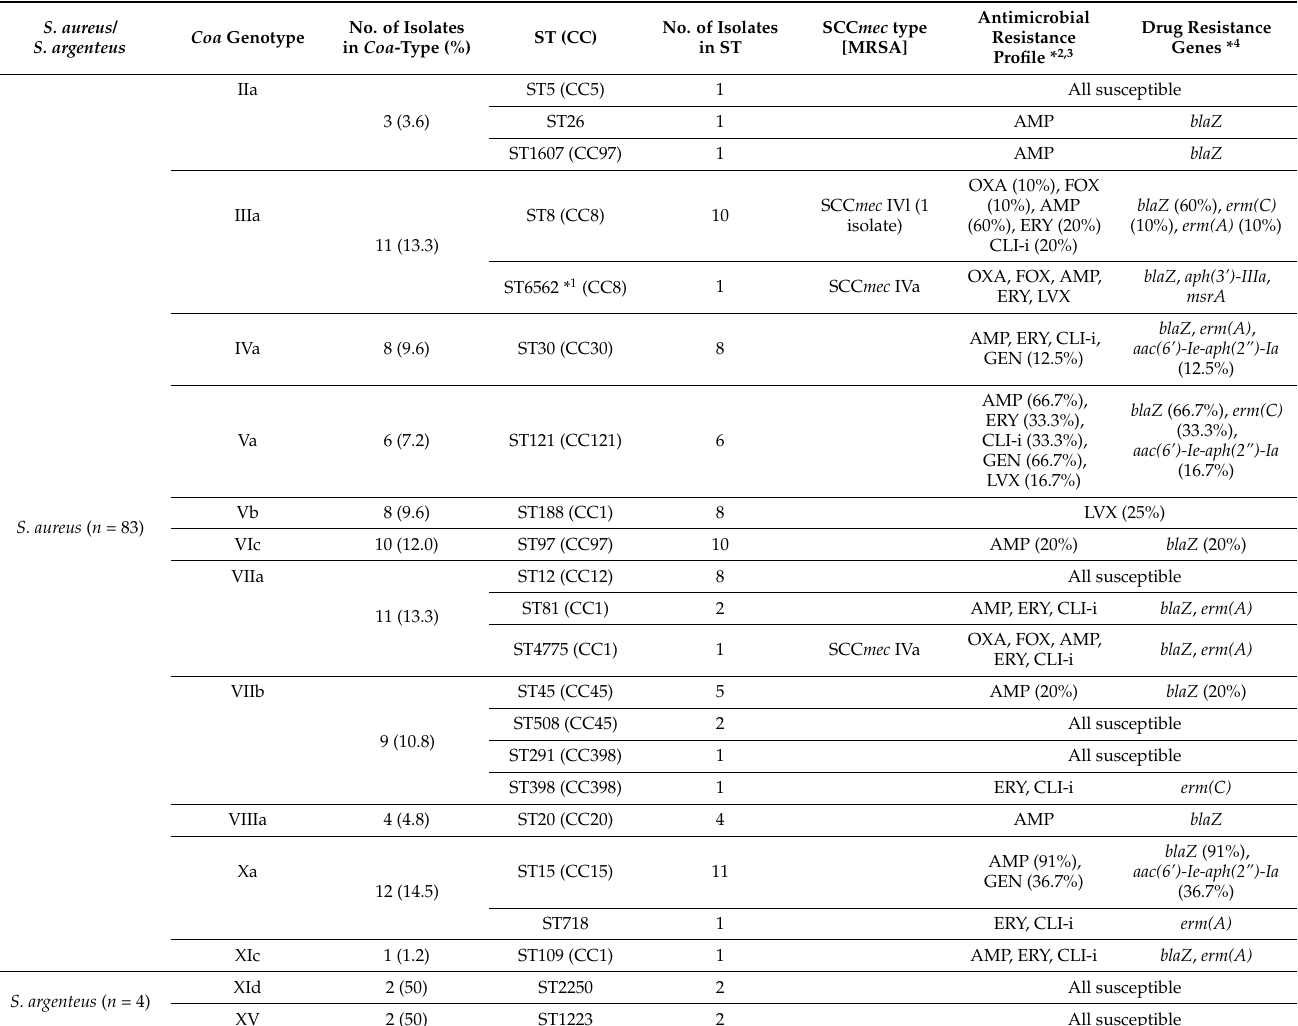
Table 2. Prevalence of coa genotype, ST, drug resistance genes and antimicrobial resistance profiles of S. aureus ( n = 83) and S. argenteus ( n = 4)